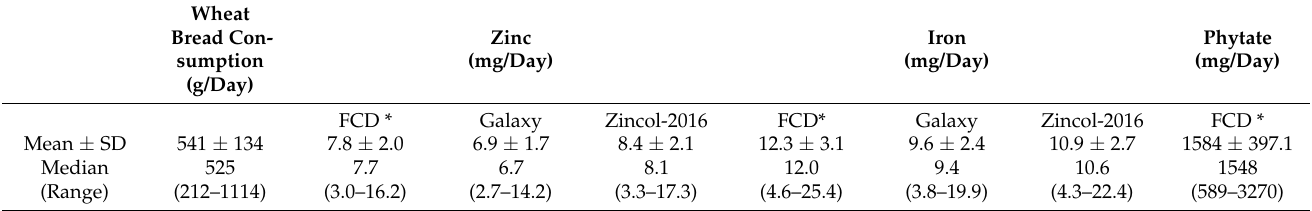
Table 4. Consumption of wheat bread and corresponding zinc, iron and phytate intakes ( n = 412).